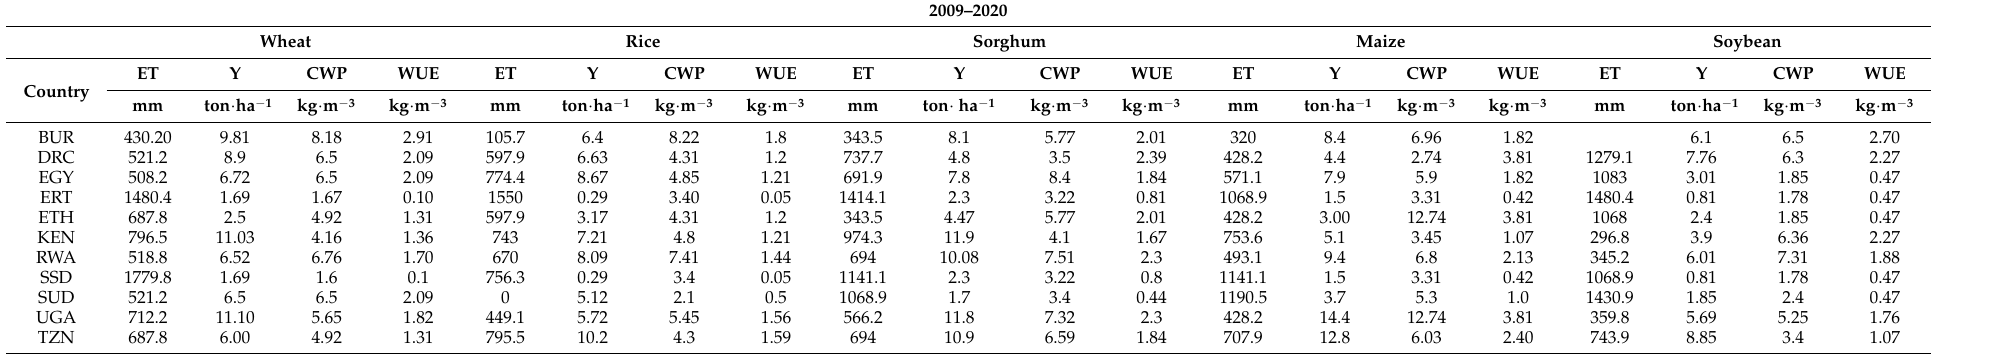
Table 4. Average yield and ET values for CWP and WUE in the NRB countries for